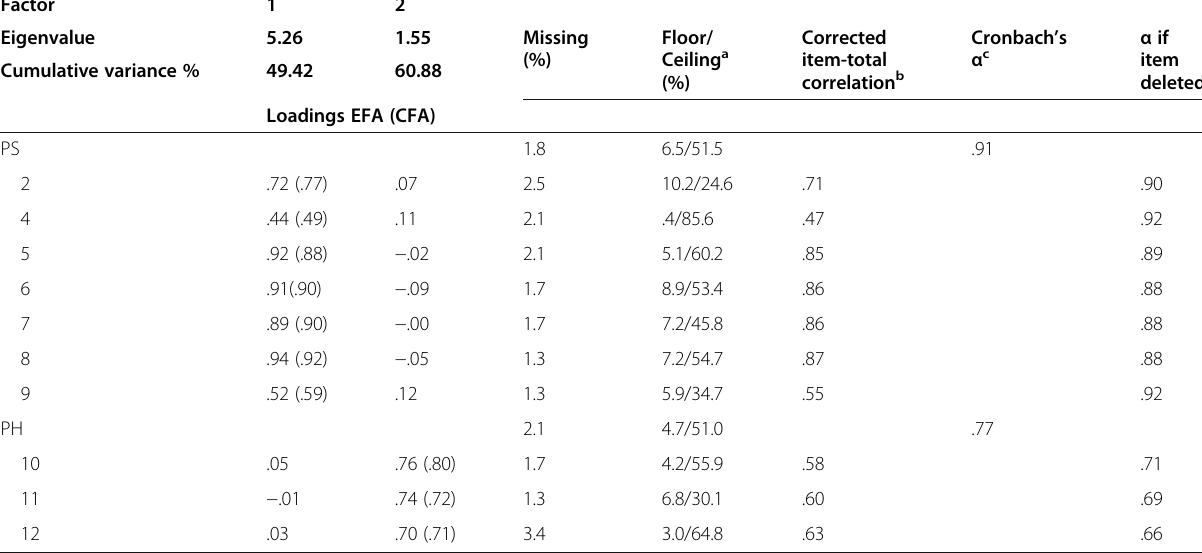
Table 5 Nuss Questionnaire modified for Adults: construct validity, missing, responses, floor/ceiling effects, and reliability Factor